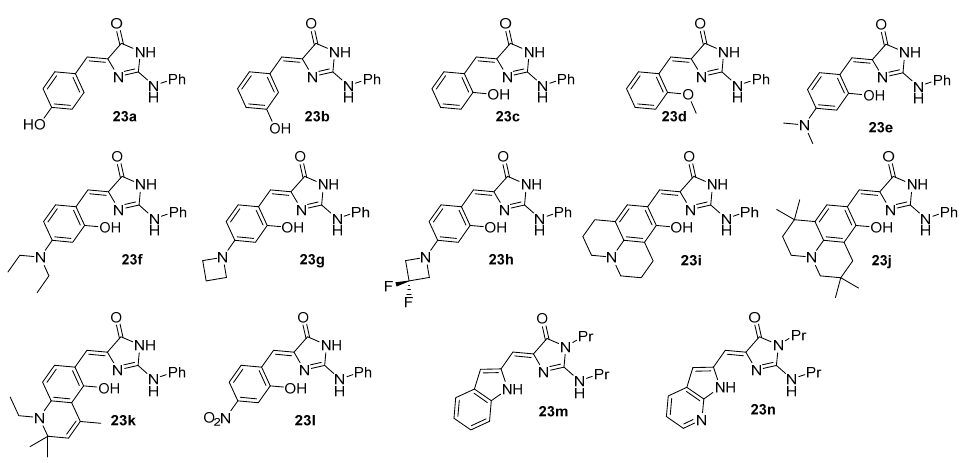
Figure 23. GFPc analogues with a benzimidazole ring substituted with nitrogen, and intramolecular hydrogen bond [38,39].